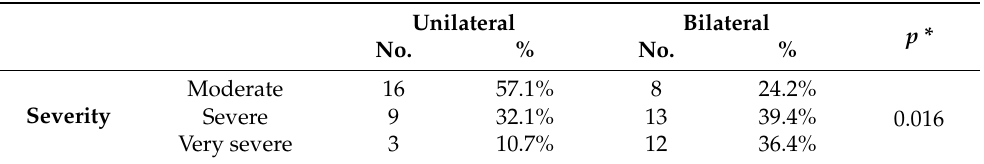
Table 3. Distribution of the patients according to the position of the affected molars and the severity of ectopic